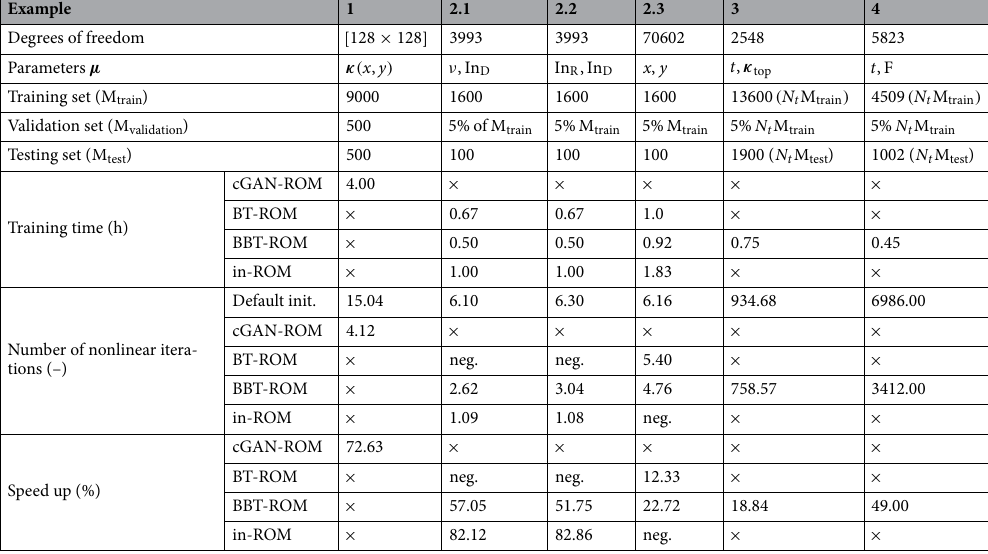
Table 1. Summary of main information for each example. Example 1 has heterogeneous parameters, and its FOM relies on structured grids - DOF = [ DOF x , DOF y ] . Examples 2, 3, and 4 have homogeneous parameters, and their FOMs use unstructured meshes. Speed up is calculated by the difference between a number of nonlinear iterations using ROM-assisted and default initialization, then divided by a number of nonlinear iterations of default initialization. neg. represents a case where using ROM-assisted causes an incremental cost (i.e., negative affect), default init. is shorted for default initialization, and × represents not applicable. The prediction cost of in-ROM is much higher than the rest, which also affects the actual speed up. We discuss this effect on the actual cost saving in Example 2. Since we observe a better as well as stable performance of BBT-ROM in Example 2, we only apply BBT-ROM to Examples 3 and 4. For steady-state problems (Examples 1 and 2), we have a training set of M train . For transient problems (Examples 3 and 4),we have a training set of N t M train . The same goes with validation and testing